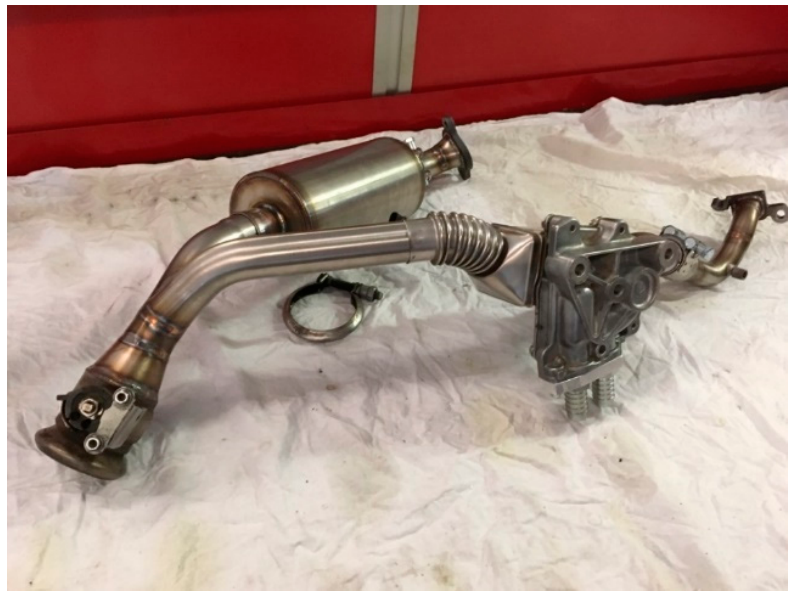
Figure 3. Picture of the exhaust piping relative to the RCCI cylinder, including the recirculation system and the exhaust gas cooler.